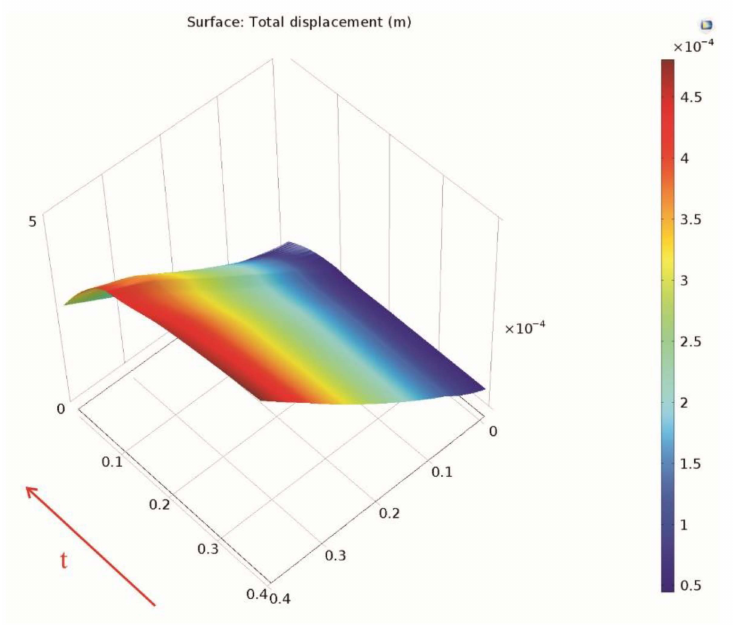
Figure 13. Variation in time of the deformation along the Cut Line 3D data set. The von Mises effective stress induced in the drum brake lining and shoe couple, at the time t = 9 s, is maximal towards the exterior drum lining surface (Figure 15), where contact with the brake shoe arises; a determined value of 1.03 × 10 8 N/m 2 resulted from simulation. This type of stress appears when a certain body subjected to heat and, thus, deformation is not allowed to expand or contract